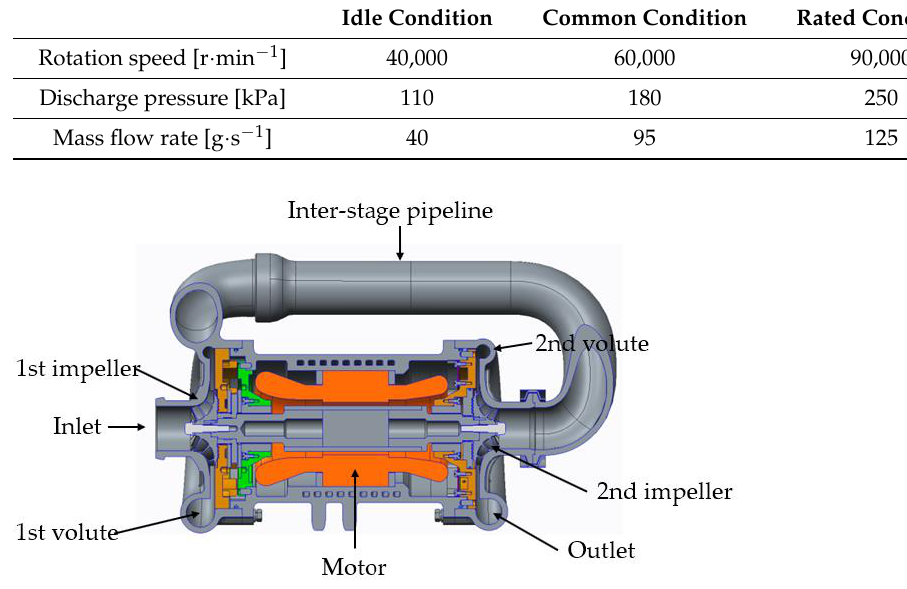
Figure 2. Cross-section of the compressor.